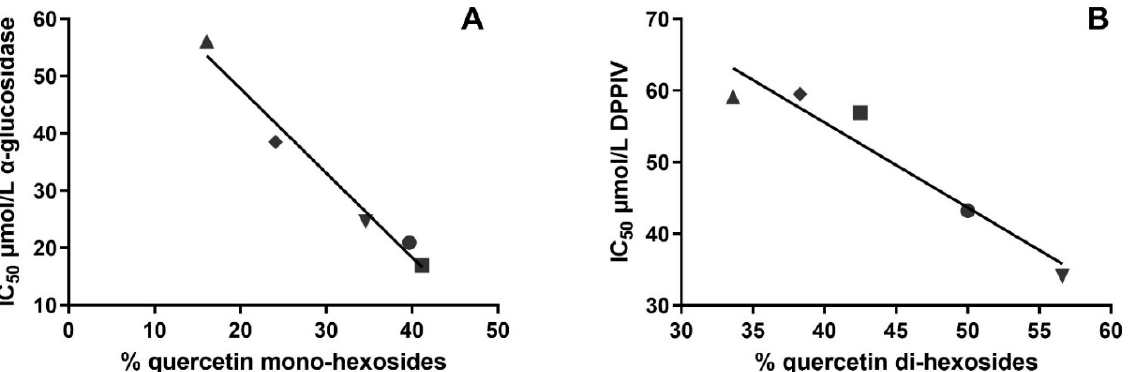
Figure 5. Linear regression analysis. ( A ) Relationship between the content of quercetin mono- hexosides in red-skinned onion samples and the IC50 values against the enzyme α -glucosidase. ( B ) Relationship between the content of quercetin di-hexosides in red-skinned onion samples and the IC50 against the enzyme di-peptidyl-peptidase-IV (DPP-IV). The symbol ▲ identifies boiled samples, ♦ grilled samples, ● fried samples, ■ raw samples, and ▼ baked samples.